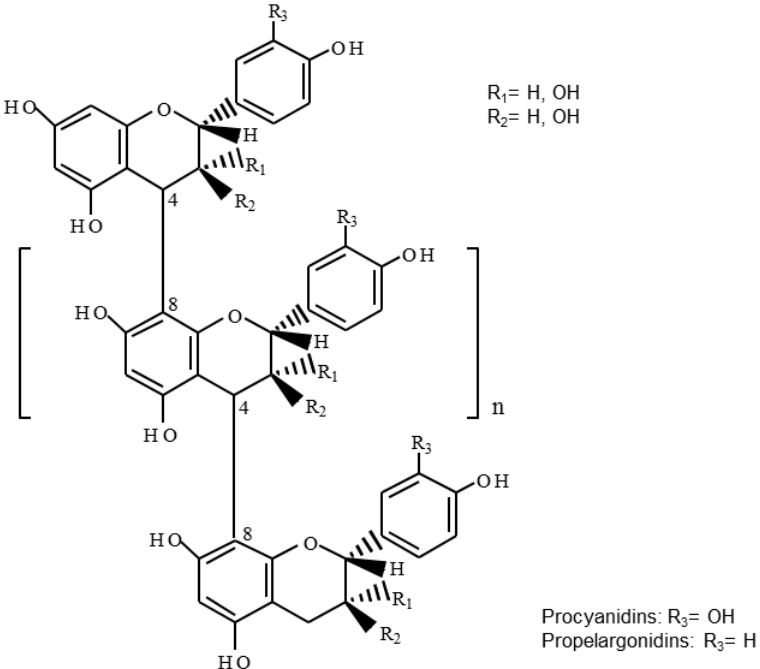
Figure 1. General chemical structure of B-type proanthocyanidins (composed by (epi)catechin units) and propelargonidins (composed by (epi)afzelechin units).